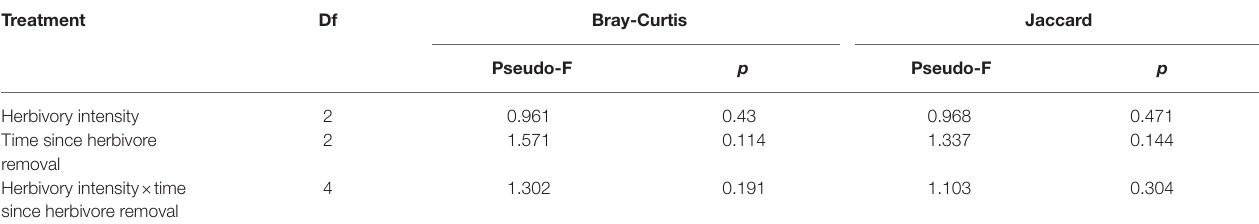
TABLE 1 | PERMANOVA analysis of the dissimilarity of soil fungal communities as affected by different herbivory intensities and time since herbivore removal. Treatment Df Bray-Curtis Jaccard Pseudo-F p